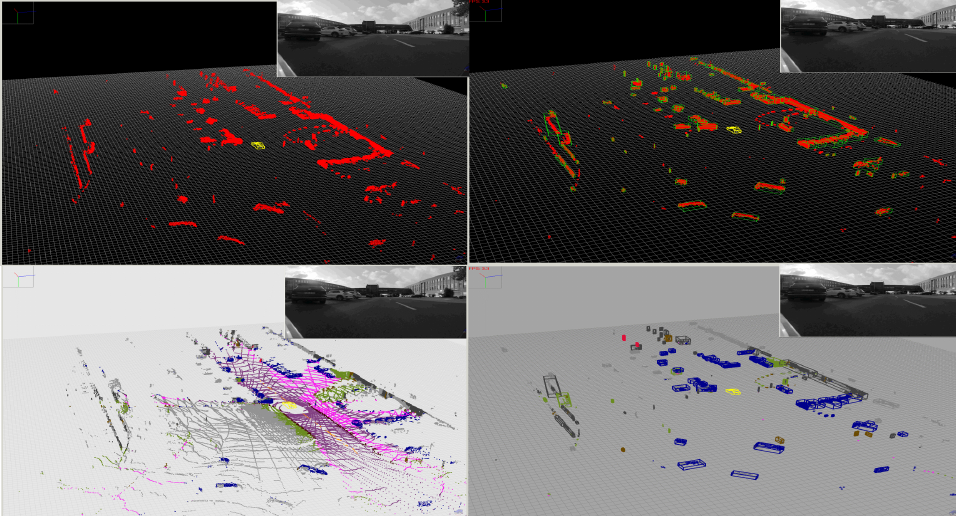
Figure 12. Results of Object Detection and Classification. Top-Left : Input LiDAR Point Cloud, Bottom-Left : STAR Point Cloud, Top-Right : Segmented Objects, Bottom-Right : Classified